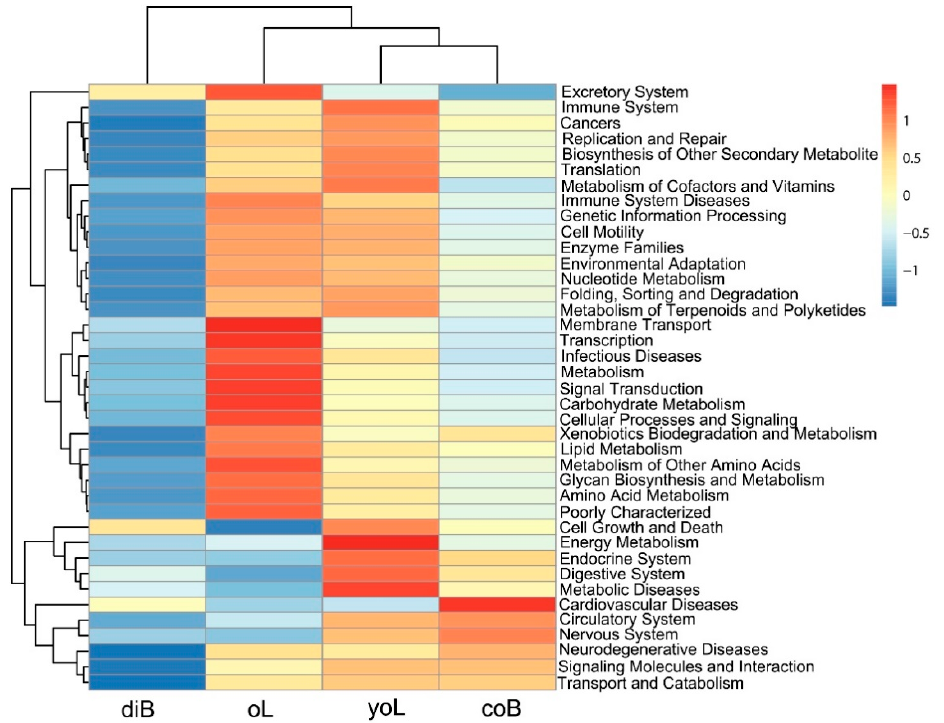
Figure 4. Heatmap of relative abundance of inferred functions by phylogenetic investigation of communities by reconstruction of unobserved states (PICRUSt) in the gut bacterial community of D. valens across its life cycle.